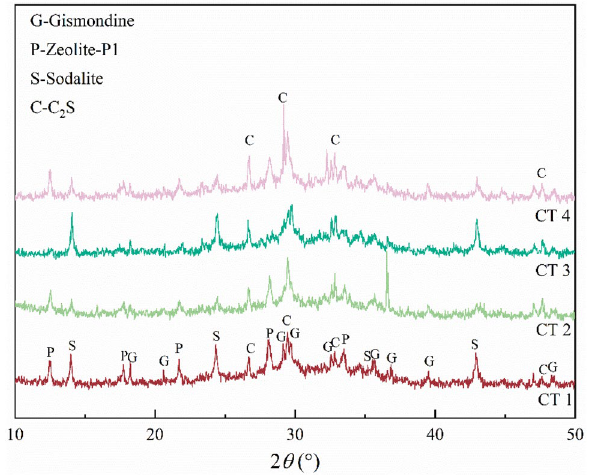
Figure 6. XRD patterns of hydrothermal products with different curing temperatures; CT 1: curing temperature it 40 °C, CT 2: curing temperature at 60 °C, CT 3: curing temperature at 60 °C, CT 4: curing temperature at 80